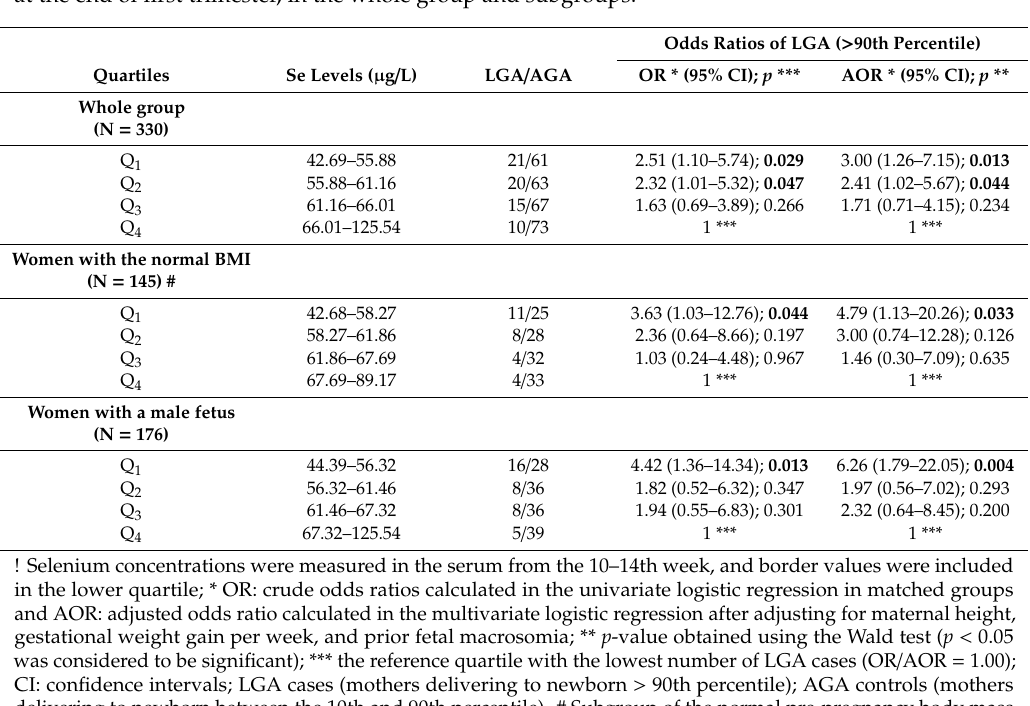
Table 3. The adjusted odds ratios of LGA ( > 90th percentile) for maternal selenium levels in the serum at the end of first trimester, in the whole group and subgroups.